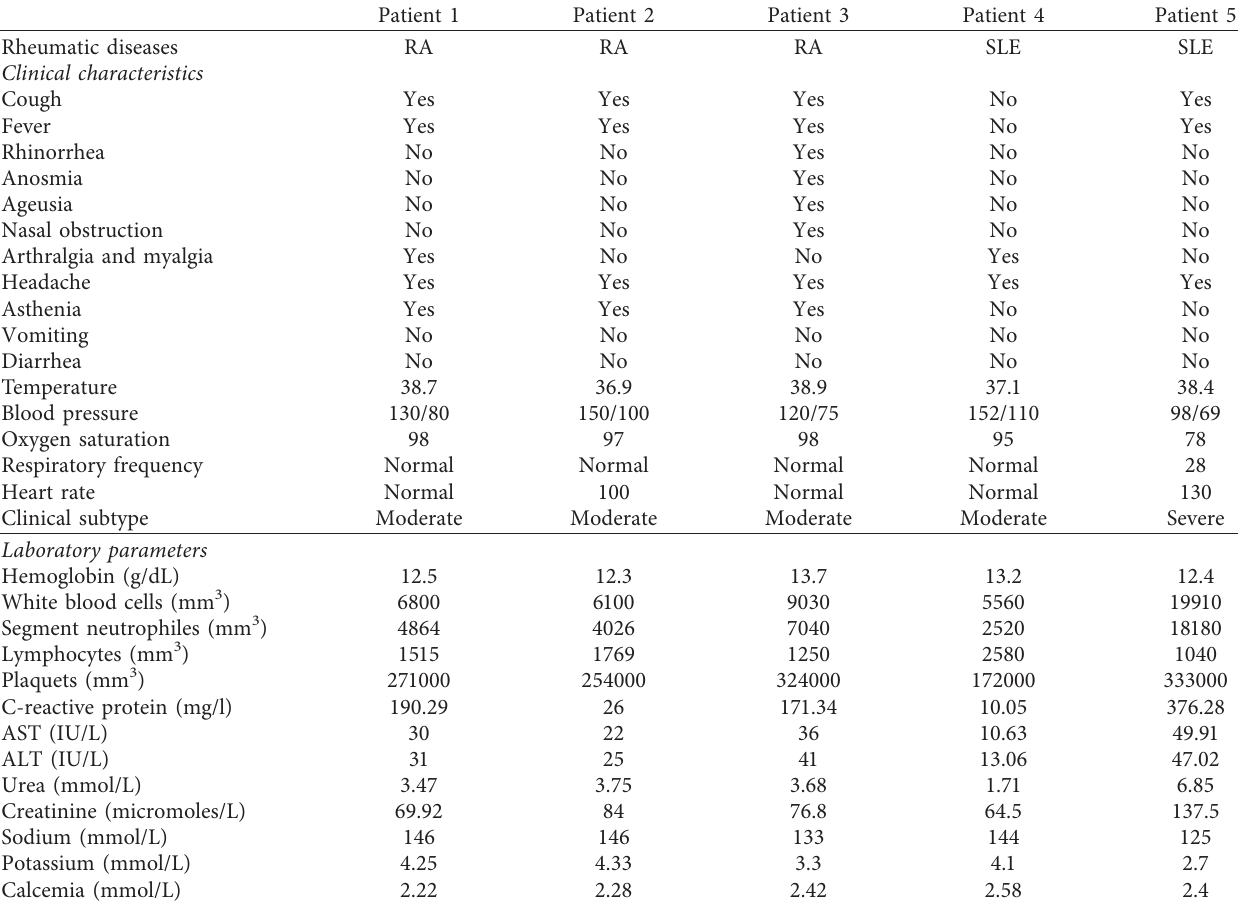
Table 1: Clinical characteristics and laboratory test of 5